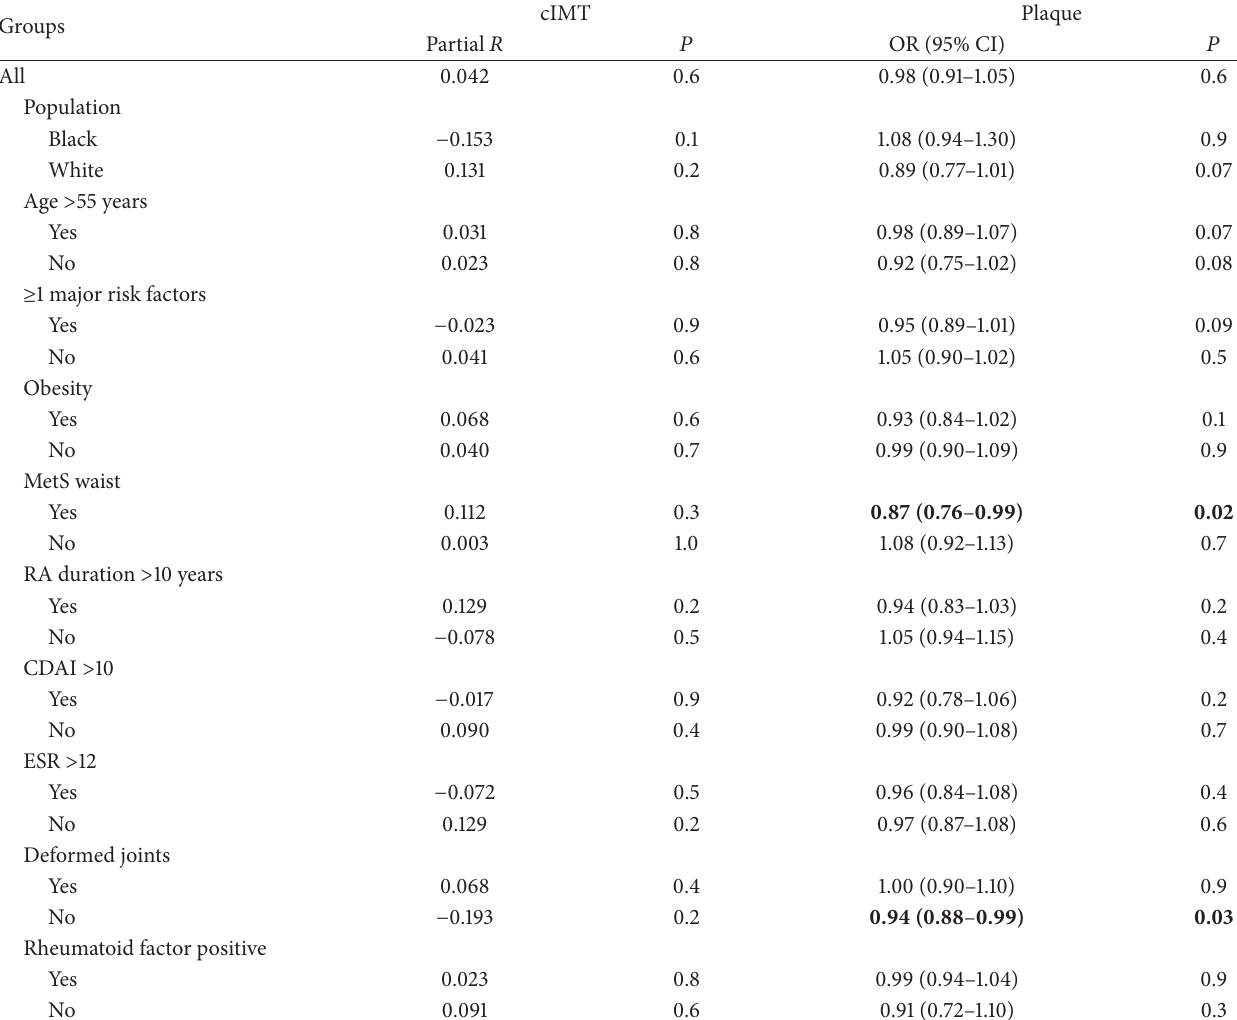
Table 3: Independent relationships of total adiponectin concentrations (1 SD increment) with carotid atherosclerosis in all RA patients and